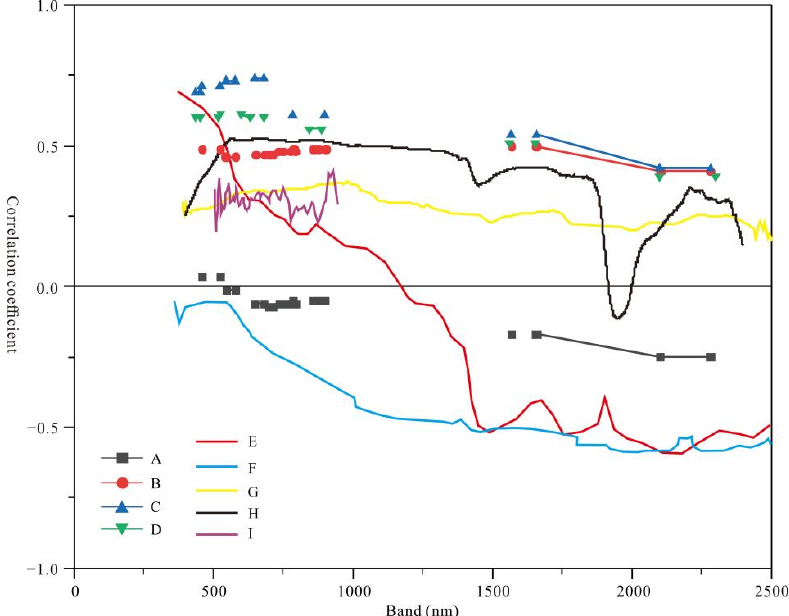
Figure 11. The comparison of correlation coefficient between bands and soil salinity from different studies. Figure A and B were redrawn from Zhou et al. [80] and Xu et al. [81], respectively. Figure C, D were redrawn from Wang et al. [79]. Figure E and F was redrawn from Wang et al. [51]. Figure F was redrawn from Mashimbye et al. [5]. Figure G, H, and I were the coefficient for GF-5, ASD, and HJ-1A spectra in this study, respectively. Table 4. The comparison of inversion accuracy of algorithms among different